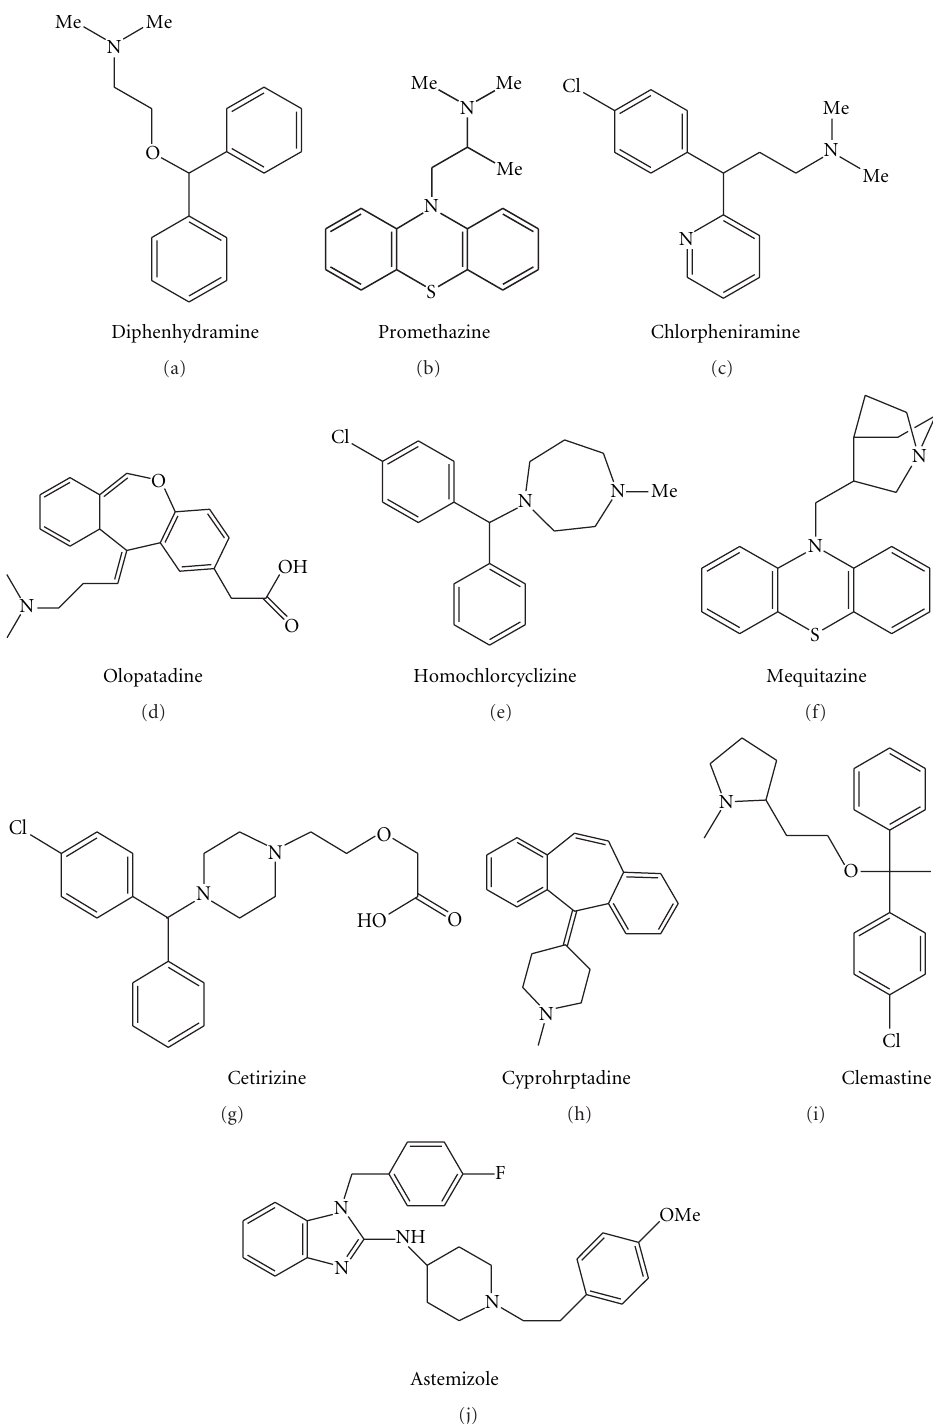
score distribution with λ = 0 . 25 using diphenhydramine Dist k = 0. The frequency was normalized; the surface area Gaussian